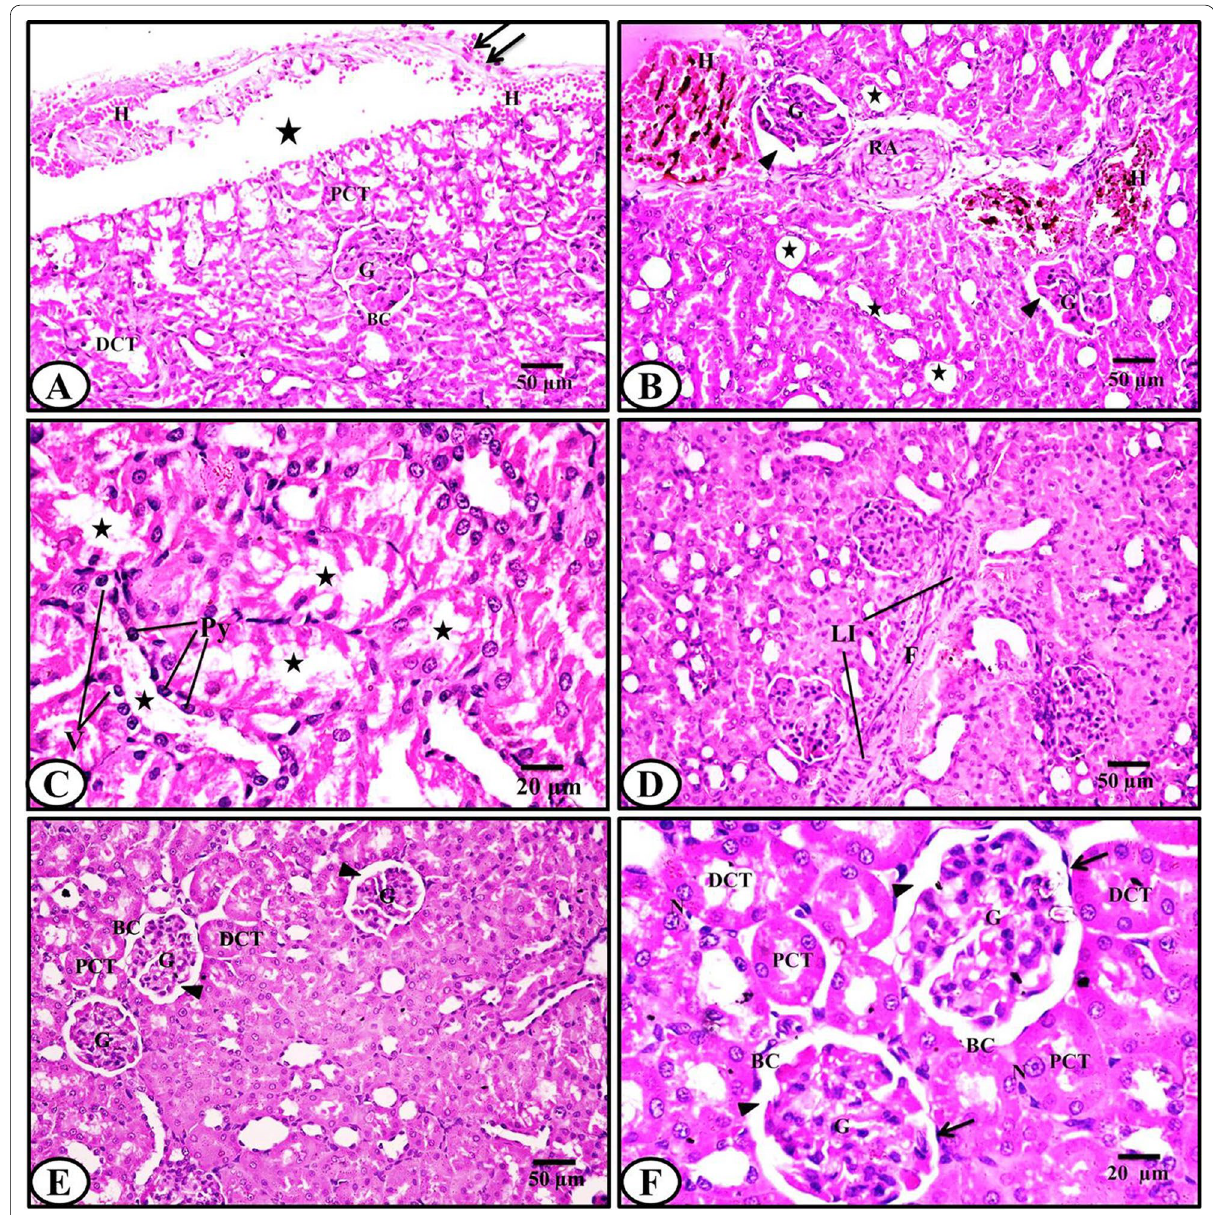
Fig. 4 Photomicrographs from hematoxylin‑ and eosin‑stained kidney sections of ( A – D ) MTX‑treated rats showing separation of the capsule (double arrow) from the renal cortex by a wide space (star) containing hemorrhage (H), Malpighian corpuscles with damaged glomeruli (G), Bowman’s capsule (BC) and dilated Bowman’s spaces (arrowheads), proximal (PCT) and distal (DCT) convoluted tubules with dilated lumens (stars) and lining epithelial cells with vacuolated cytoplasm (V) and pyknotic nuclei (Py), congested renal artery (RA), leukocytic infiltration (LI) and fibers (F) and E&F ) MTX and HPE‑treated rats showing nearly normal Malpighian corpuscles with Bowman’s capsule (BC) with squamous epithelium (arrows), Bowman’s spaces (arrowheads) and glomeruli (G) and proximal (PCT) and distal (DCT) convoluted tubules